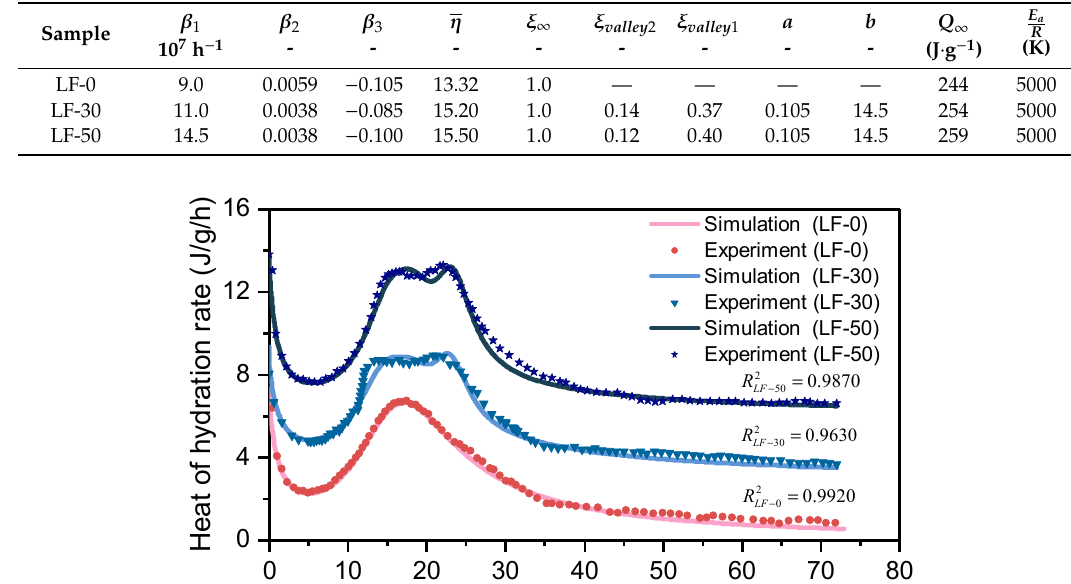
Table 5. The parameters of the hydrothermal model.